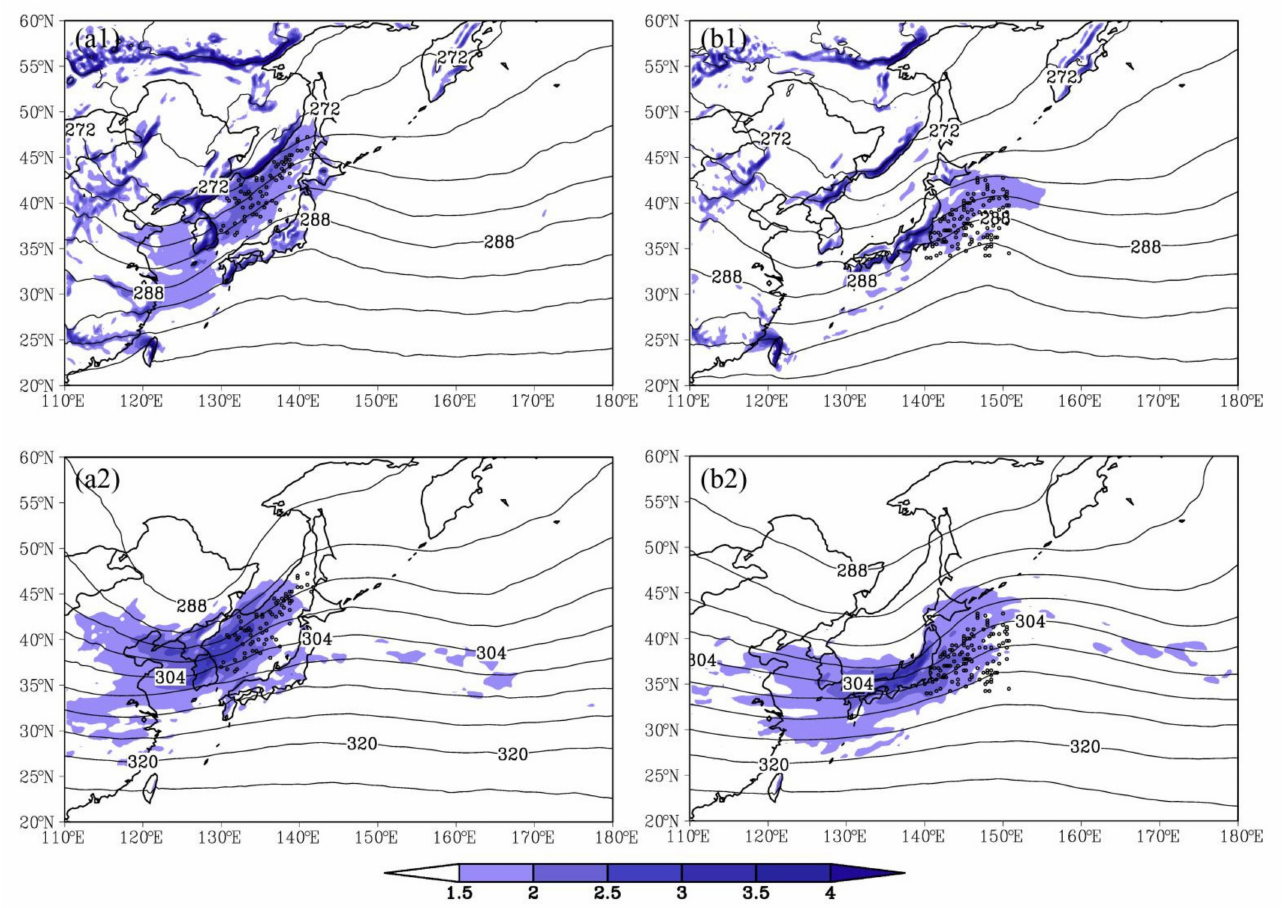
Figure 7. Composite fields of potential temperature (solid line, 4 K intervals) and baroclinicity (shaded, 0.5 × 10 − 5 K m − 1 intervals) for ECs at maximum-deepening-rate moment over ( a1 , a2 ) the Japan Sea and ( b1 , b2 ) Kuroshio/Kuroshio Extension at ( a1 , b1 ) 850 hPa and ( a2 , b2 ) 500 hPa. ” ◦ ” is the EC center at maximum-deepening-rate